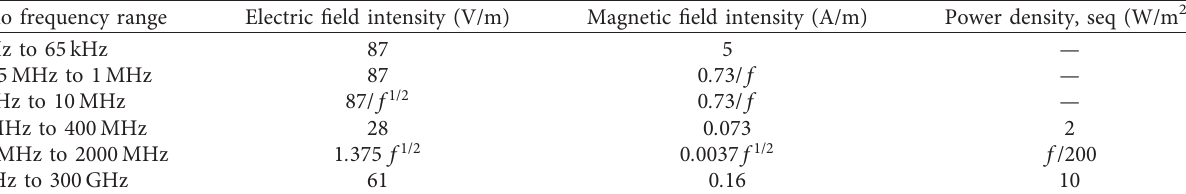
Table 1: Limits of the general public exposure to electromagnetic fields in the range of frequencies between 8.3kHz and 300GHz [13].